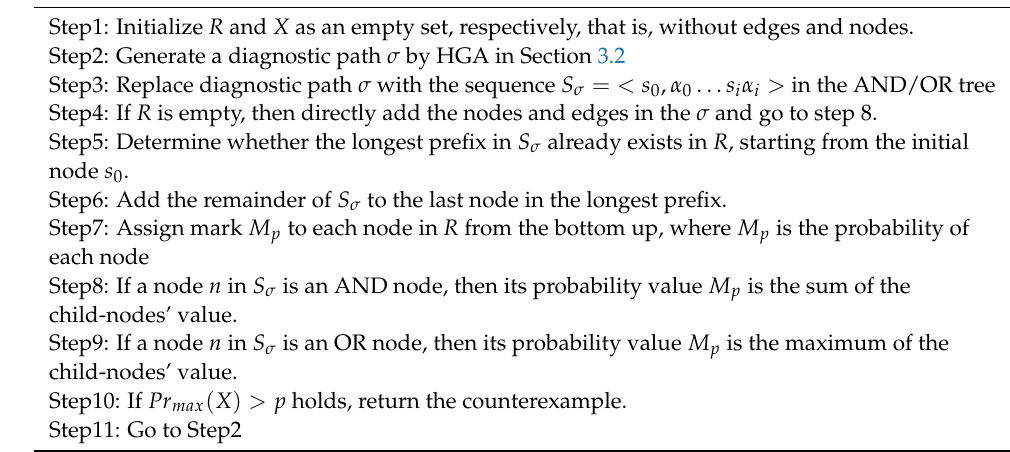
Algorithm 2. Counterexample generation for MDP with